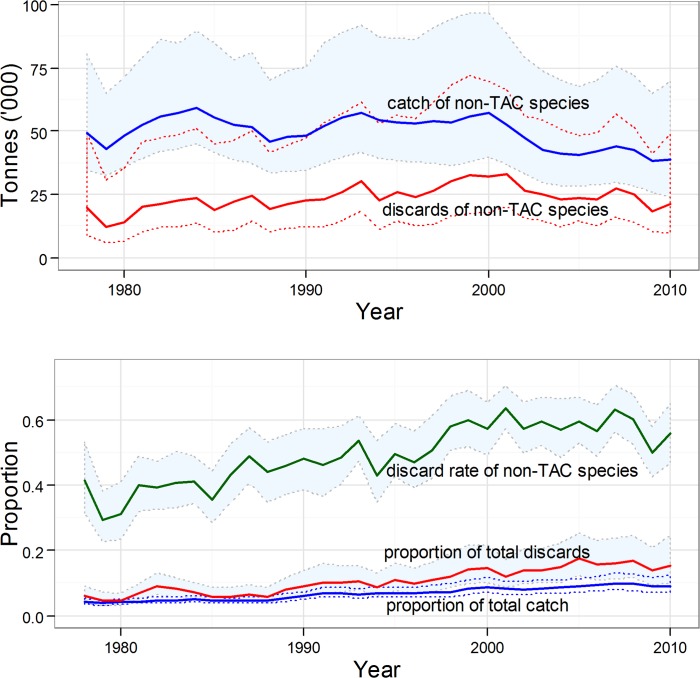
Model results for non-TAC species.(a) Annual catch and discard quantities (tonnes) for the group of species which, in 2010, were not subject to any landing quota (TAC) restrictions (bass, gurnards, halibut, ling, mullets, pollack, tusk, wolfish, and the ‘other marketable’ and ‘discard-only’ groups). (b) catch and discards of non-TAC species as proportions of total demersal catch and discards (solid lines), and the discard rate (proportion of catch discarded) for non-TAC species as a group (dashed line). 95% credible intervals around each of the time series indicated by shaded regions and/or thin lines.